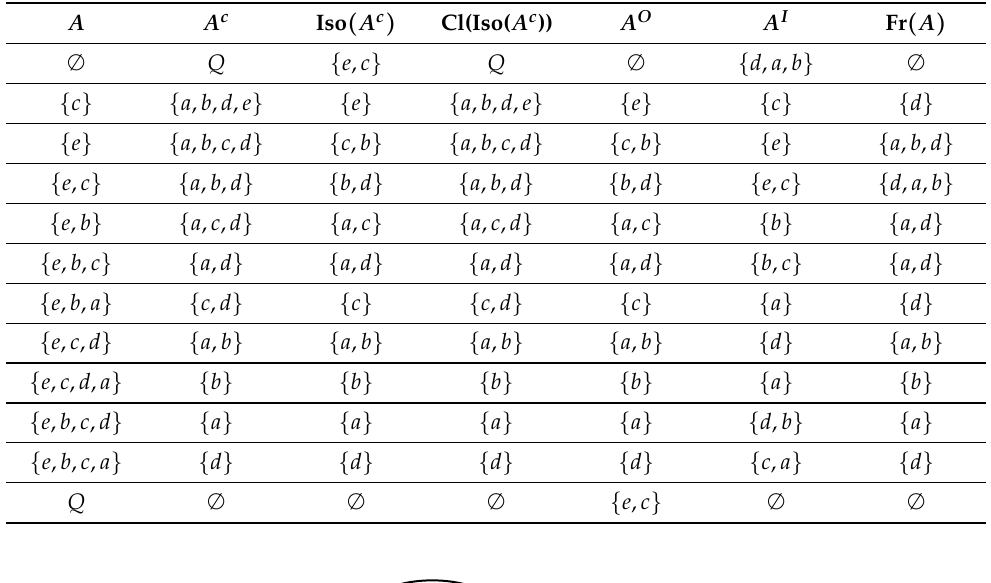
Table 3. Operations on Knowledge States in 5PS.